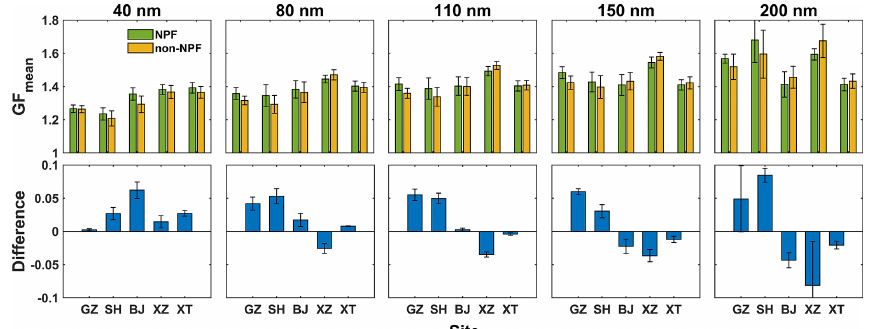
Figure 9. The mean values and differences in number-weighted mean growth factor (GF mean ) during NPF and non-NPF days for particles with the size of 40–200nm from all sampling sites. The difference represents the GF mean of NPF days minus the GF mean of non-NPF